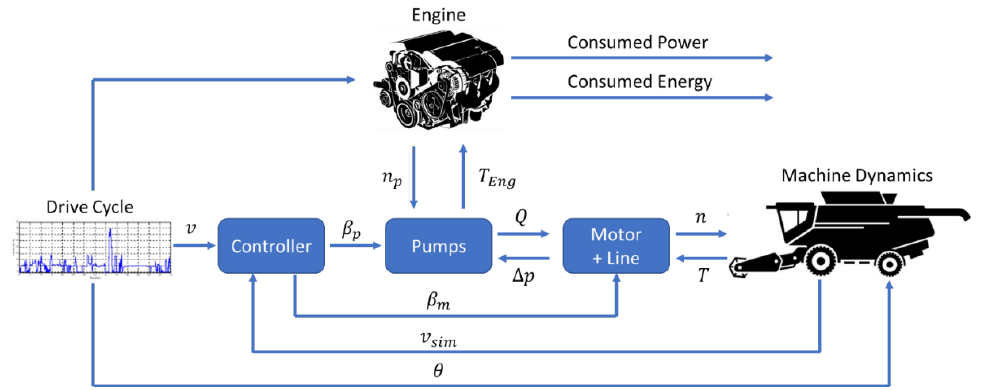
Figure 11. Transmission Block Diagram.